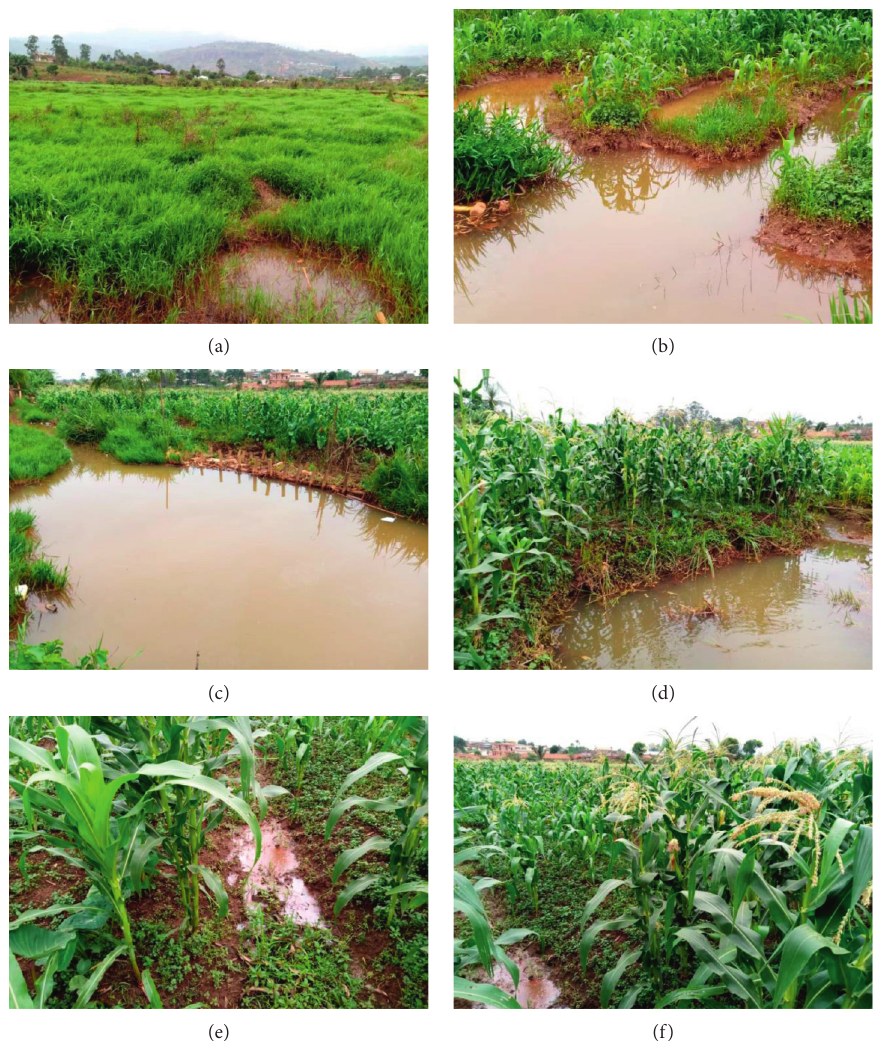
Figure 6: Photographs of wetland ecosystems in Nkwen (Bamenda). (a) Wetland with grassed vegetation; (b) water retained in furrows of raised ridges; (c, d) channeling of water into farmlands for irrigation; (e, f) healthy maize crops cultivated in the wetlands of